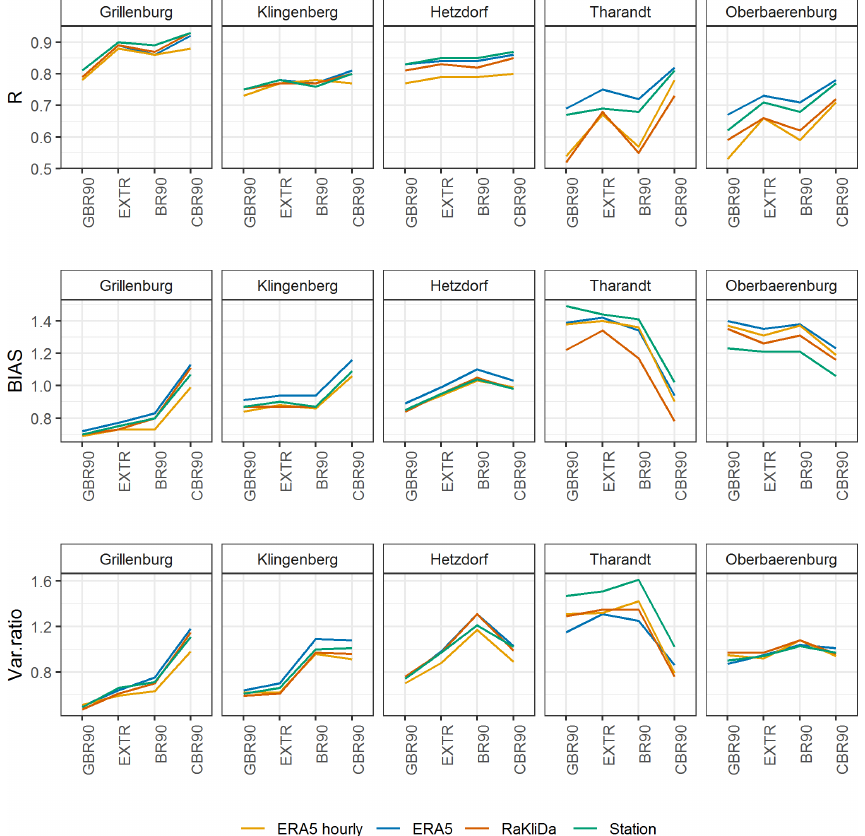
Figure 6. Decomposition of KGE for daily evaporation for the whole year: correlation, bias and variance ratio.